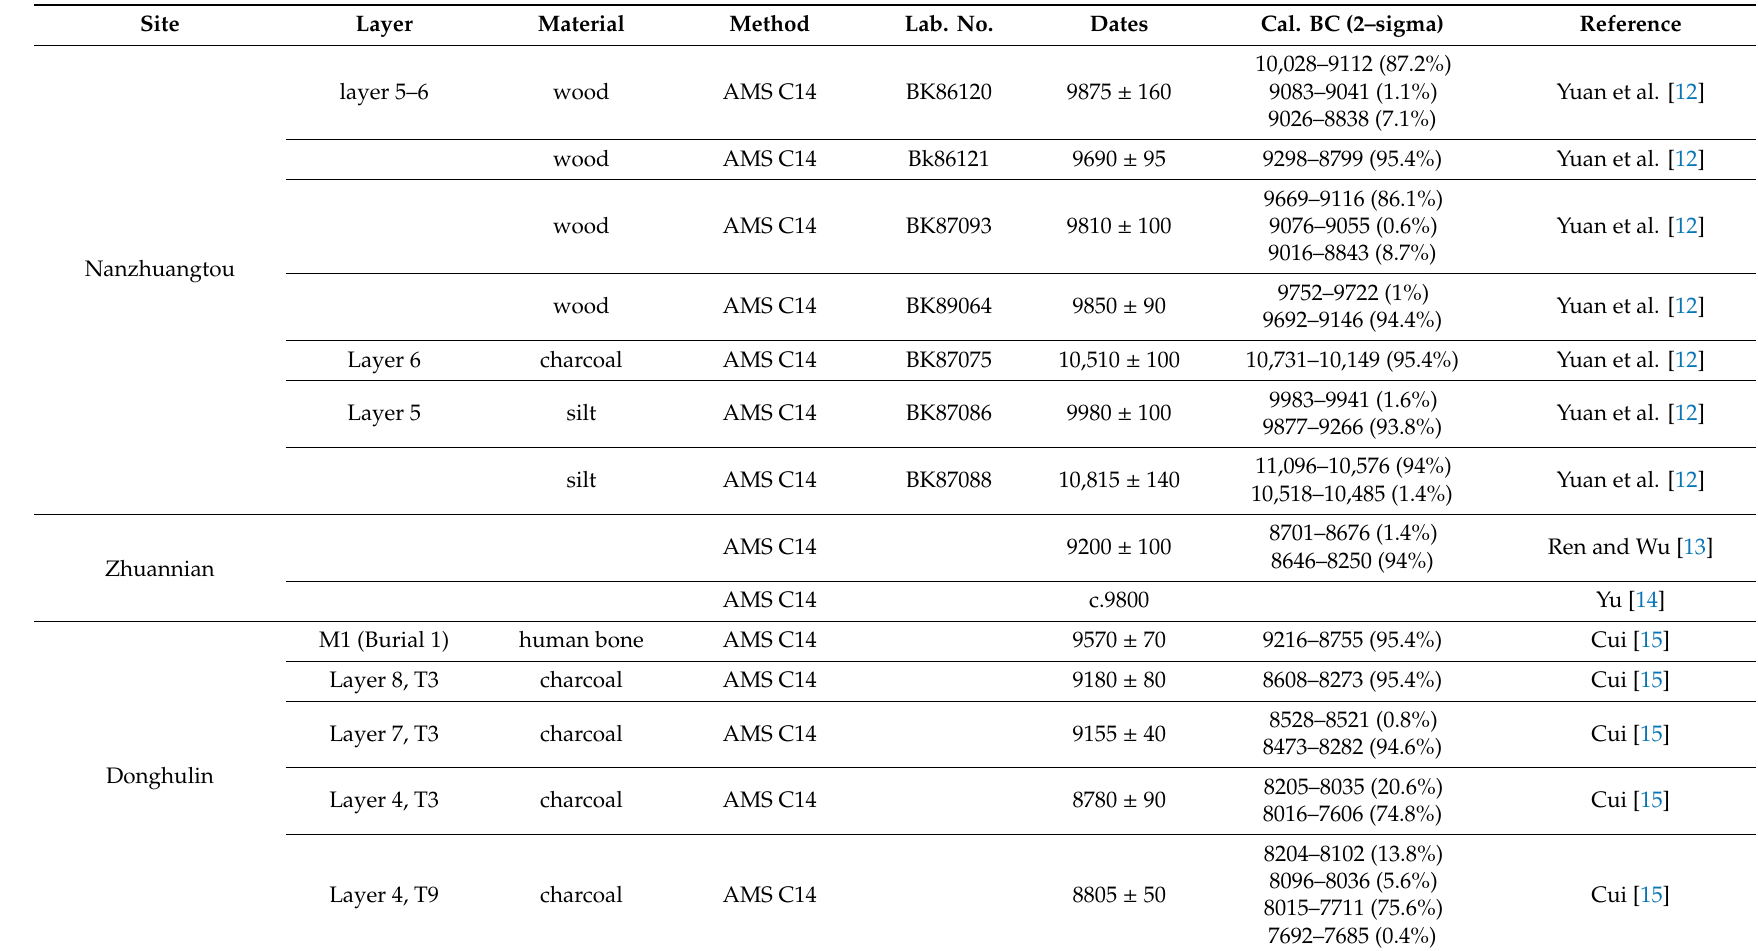
Table 2. Chronometric dates of the sites in the Paleolithic to Neolithic Transition (PNT)